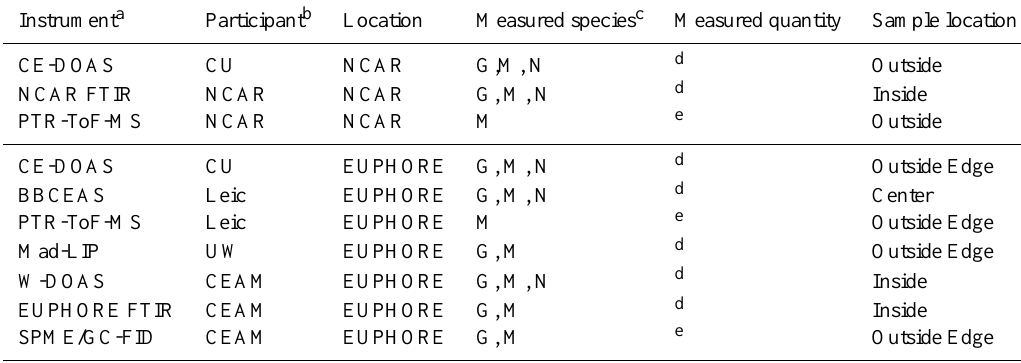
Table 1. Instrumentation and measured species at NCAR and EUPHORE. Instrument a Participant b Location Measured species